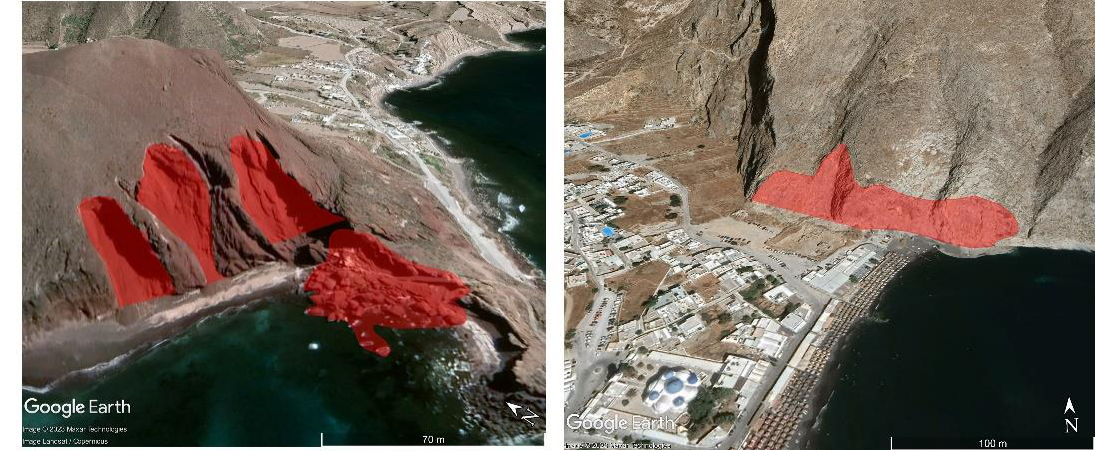
Figure 7. Google earth images representing two coastal areas on eastern Thira near to active or potential landslide triggering. (Red Beach on the left and Perissa on the right ).